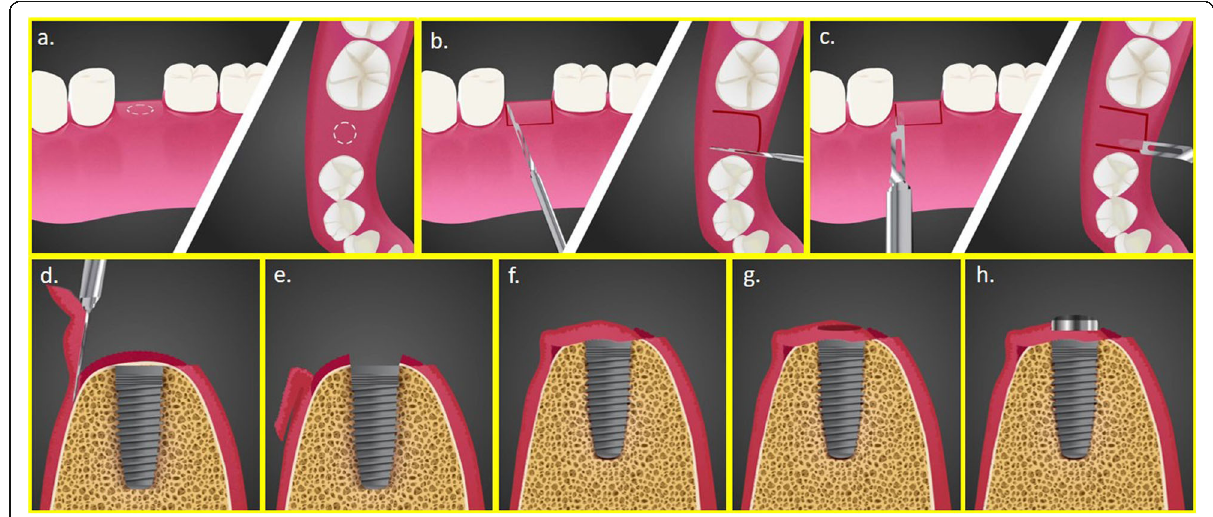
Fig. 1 Buccally displaced flap surgical technique. a Bone sounding. b Two parallel and one perpendicular incisions placed. c Partial thickness tissue dissection underneath the incisions. d Tissue dissection extending till the mucogingival junction on buccal side, and partial thickness flap reflected. e Connective tissue over the implant removed. f Partial thickness flap displaced buccally and adapted over the surface. g 3 mm tissue punch. h Healing abutment to secure the flap in its new